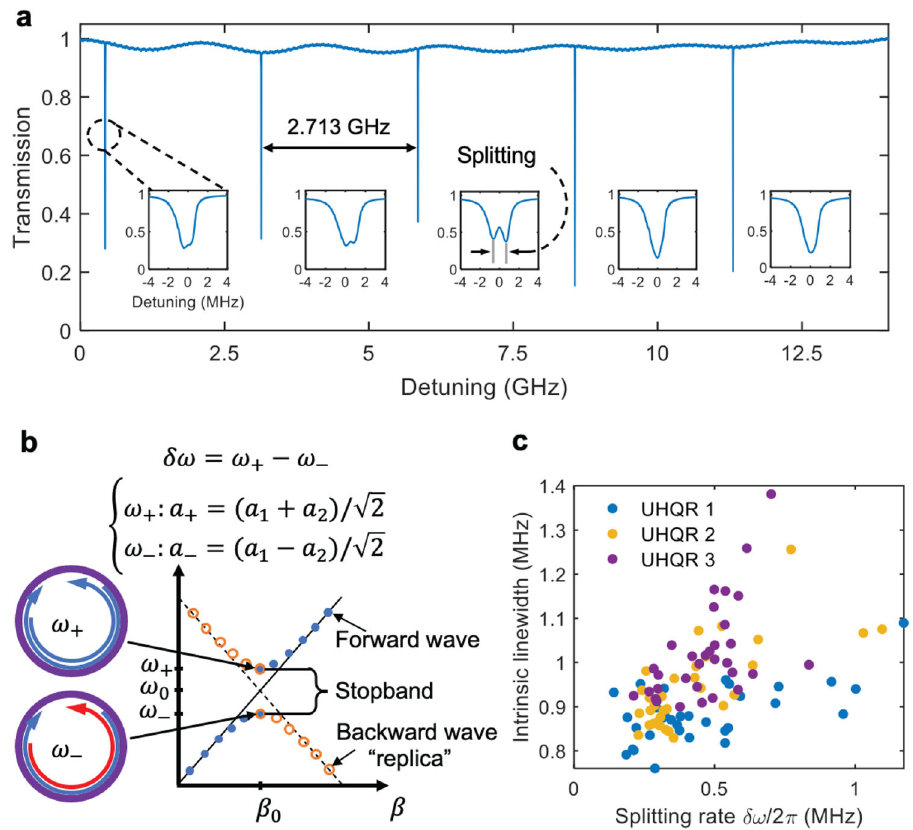
Fig. 3 Resonance splitting. a Spectral scan across fi ve free spectral ranges (FSRs) around 1550 nm con fi rms single transverse electrical fi eld (TE) mode operation, blue curve. Details of individual resonances reveal random splitting. b Resonance splitting via coupling between forward and backward propagating waves. c Scatter plot of the measured intrinsic linewidth versus the splitting rate near 1550 nm for three ultra-high Q resonator (UHQR) devices fabricated on the same wafer. Blue dot, yellow dot, and purple dot represent UHQR1, UHQR2, and UHQR3 devices, respectively.